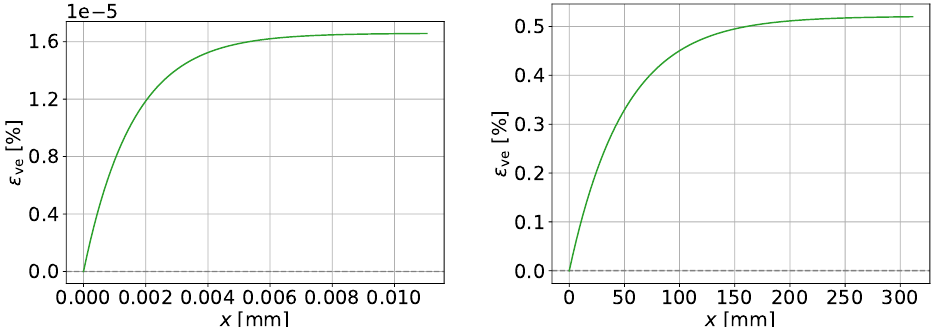
Figure 8. Viscoelastic strain. Left : 316L steel; note scale. Right : Artificial high-viscosity example, t ret =